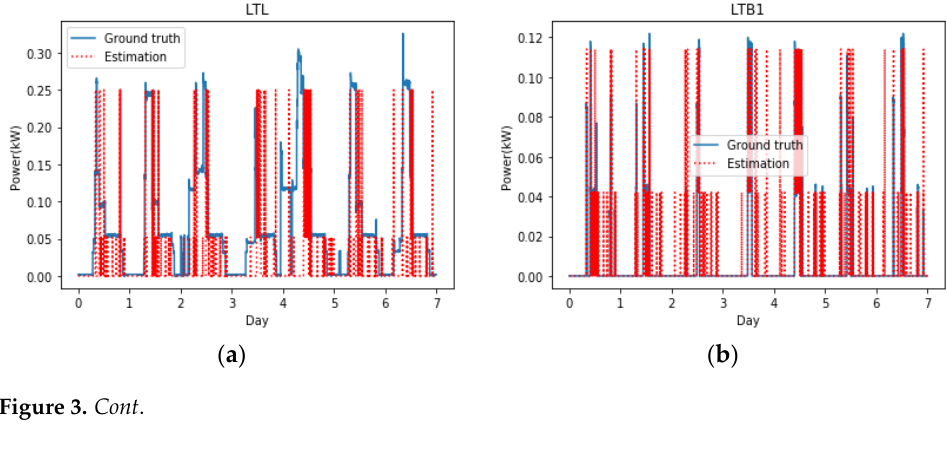
Table 6. Power demand estimation accuracy associated with the MTC